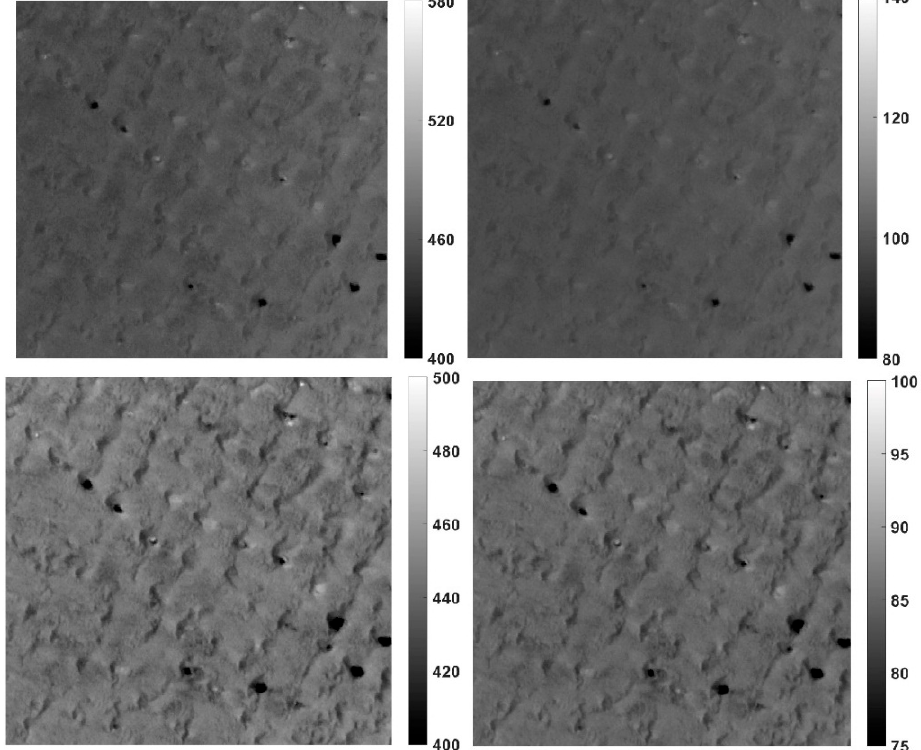
Figure 5. Example of the simulated TOA radiance and its corresponding Digital Number (DN) of GF-4/PMS image on 15 June 2016 in blue and green bands. Table 8. Mean TOA radiance and DN for every GF-4/PMS image.